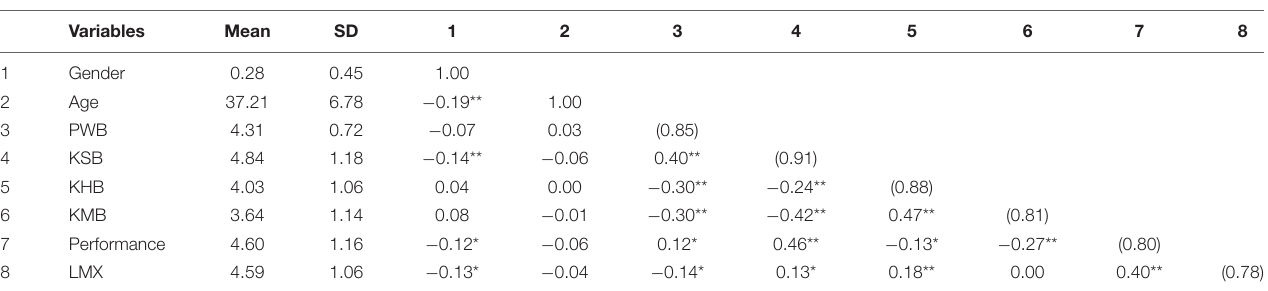
TABLE 1 | Means, standard deviations, and correlations for all variables.